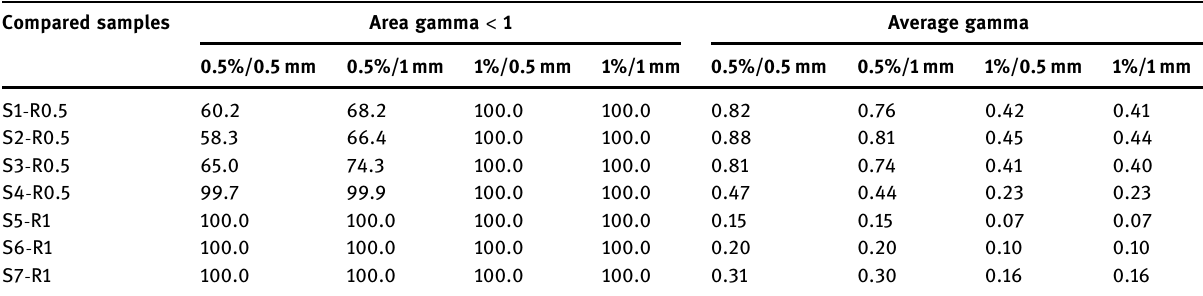
Table 1: Results of gamma analysis calculated with Portal Dosimetry for the four sets of acceptance criteria Compared samples